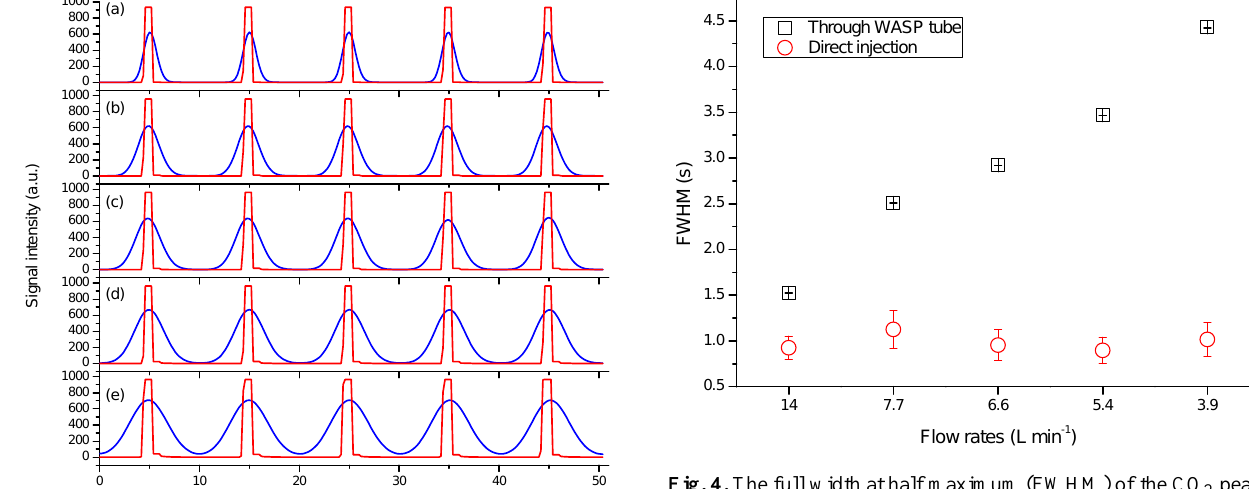
Fig. 4. The full width at half maximum (FWHM) of the CO 2 peaks as shown in Fig. 3. Each data point corresponds to the mean FWHM value of the five CO 2 peaks under each condition. Error bars indi- cate one standard